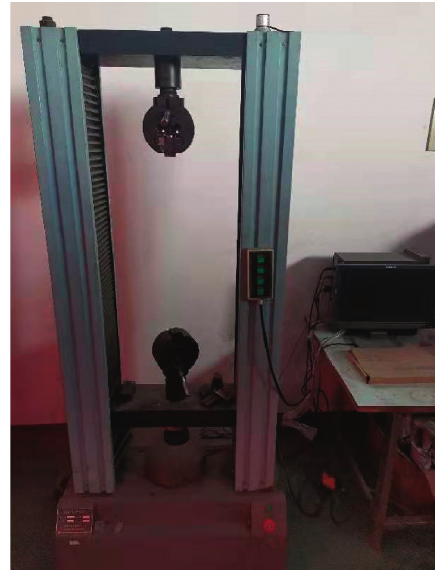
Figure 8: Microcontrol electronic universal testing machine.